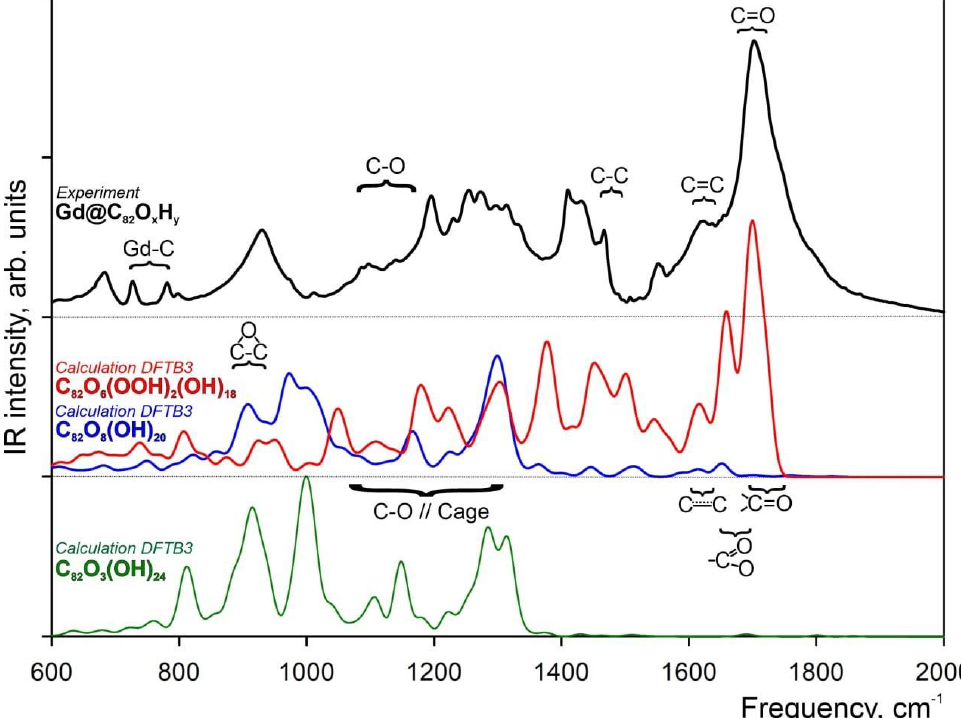
Figure 1. Experimental FTIR spectrum of Gd@C 82 O x H y and theoretical spectra of C 82 O x H y possible isomers. Top: Experimental FTIR spectrum of Gd@C 82 O x H y in the KBr matrix (black curve). Bottom: Theoretical IR spectra of free − standing C 82 O 3 (OH) 24 (green curve). Middle: Theoretical IR spectrum of I 1 isomer (C 82 O 8 (OH) 20 , blue curve), and theoretical IR spectrum of I 2 isomer (C 82 O 6 (OOH) 2 (OH) 18 , red curve). Theoretical IR spectra calculated in the gas phase at the DFTB3 level of theory.